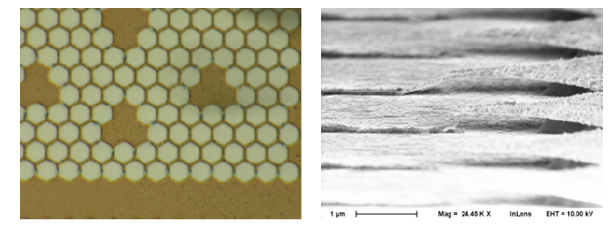
Figure 10. Image of a collapsed ePID chip taken by microscope (left) and scanning electron microscope (right).